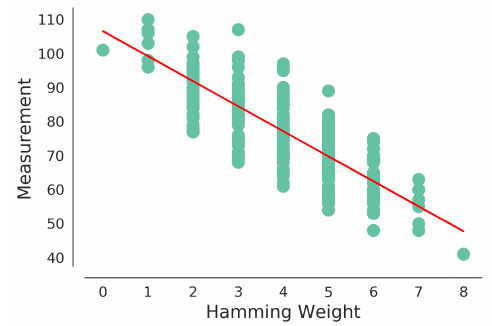
Figure 31: Measured leakages vs. actual Hamming weights on the Arduino Uno.